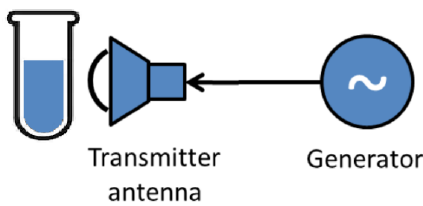
Figure 5. Scheme of the device for irradiation of the bacterial culture with radio frequency electromagnetic waves.